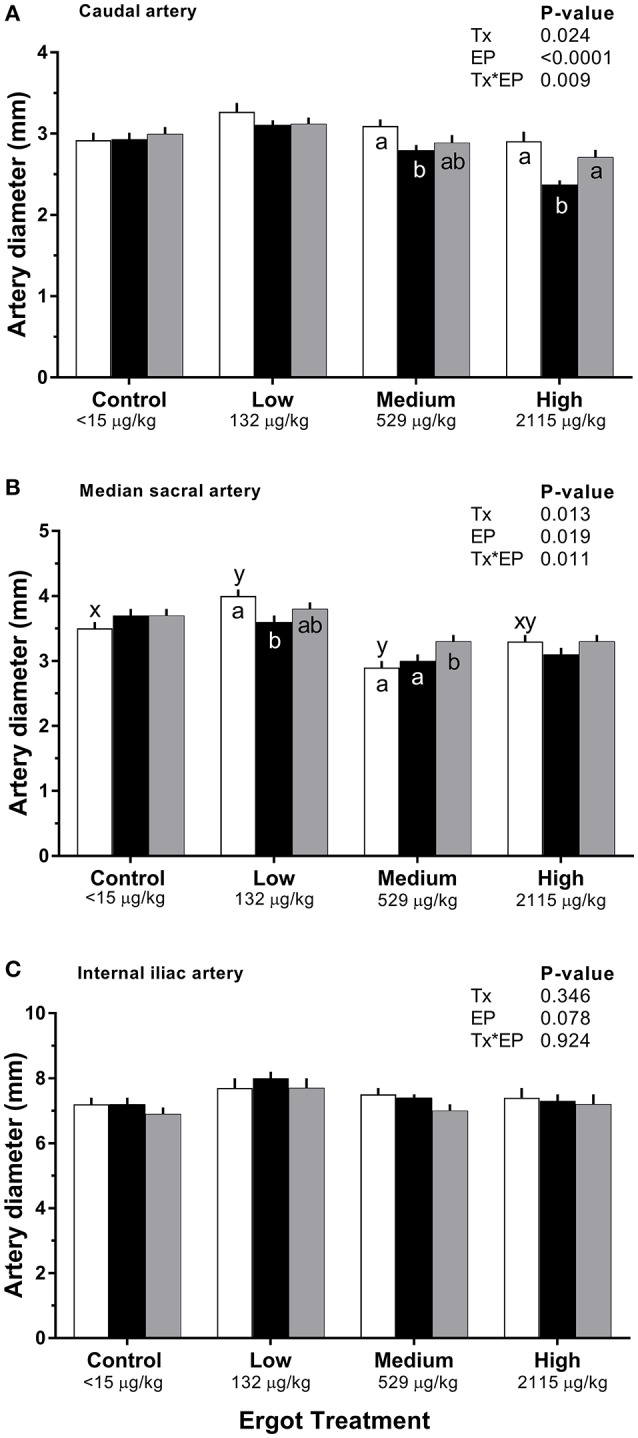
Diameter of the (A) caudal artery, (B) median sacral artery, and (C) internal iliac artery of lactating Hereford cows (n = 4 per treatment group) before (4 days), during (7 days), and after (4 days) feeding increasing concentrations of ergot alkaloids in Control (<15 μg/kg), Low (132 μg/kg), Medium (529 μg/kg), and High (2115 μg/kg) ergot groups. Each bar represented the mean±SEM for each experimental period. Repeated measures analysis was used to test for changes in arterial diameter (each artery analyzed individually) for treatment (Tx), experimental period (EP) and their interaction (Tx*EP). Differences among experimental periods within a treatment group (connected bars) are indicated by x and y (p < 0.05) and differences among groups during a given treatment period (same colored bars) are indicated by a and b (p < 0.05).